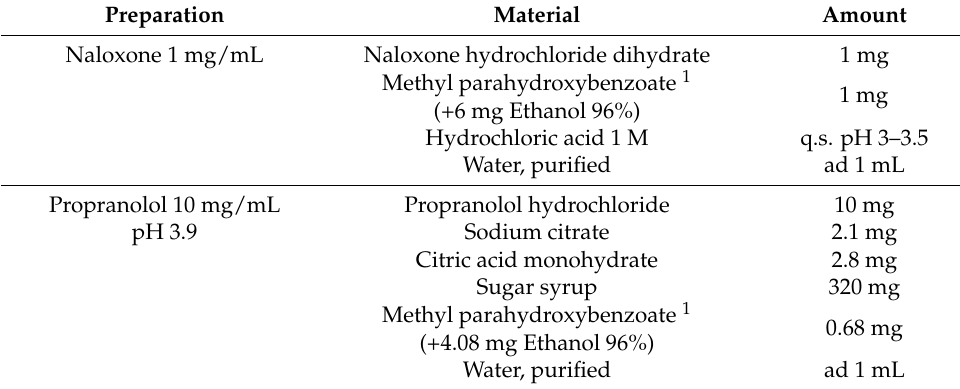
Table 3. Original composition of the two oral liquids included in the